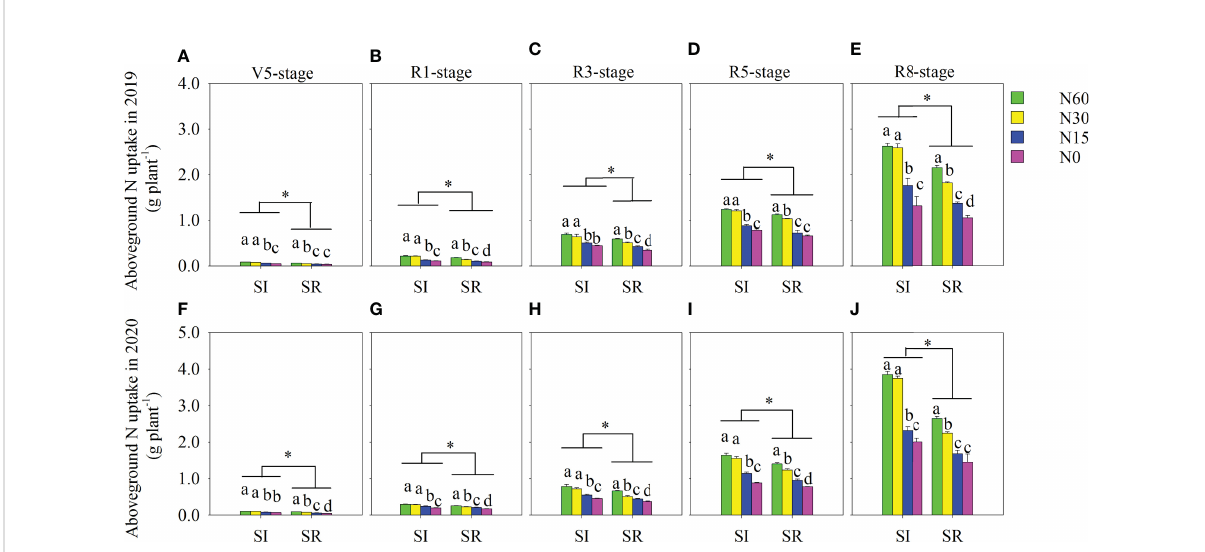
FIGURE 7 Effects of straw incorporation and nitrogen application on aboveground N-uptake of intercropped soybean at different growth stages. Different lower-case letters indicate signi fi cant differences under different N application rates ( LSD , P < 0.05). Data were shown as mean ± S.D. (n=3). The asterisk “ * ” indicates signi fi cant differences ( P < 0.05) between straw incorporation and straw remove. SI, straw incorporation; SR, straw removal; N60, convention N (60 kg N ha -1 ); N30, reduced N by 50% (30 kg N ha -1 ); N15, reduced N by 75% (15 kg N ha -1 ); N0, zero N (0 kg N ha -1 ); V5, the fi fth trifoliolate stage of soybean; R1, the beginning fl owering stage of soybean; R3, the beginning pod stage of soybean; R5, the beginning seed stage of soybean; R8, the full-maturity stage of soybean. (A) , aboveground N uptake at the V5 stage in 2019; (B) , aboveground N uptake at the R1 stage in 2019; (C) , aboveground N uptake at the R3 stage in 2019; (D) , aboveground N uptake at the R5 stage in 2019; (E) , aboveground N uptake at the R8 stage in 2019; (F) , aboveground N uptake at the V5 stage in 2020; (G) , aboveground N uptake at the R1 stage in 2020; (H) , aboveground N uptake at the R3 stage in 2020; (I) , aboveground N uptake at the R5 stage in 2020; (J) , aboveground N uptake at the R8 stage in